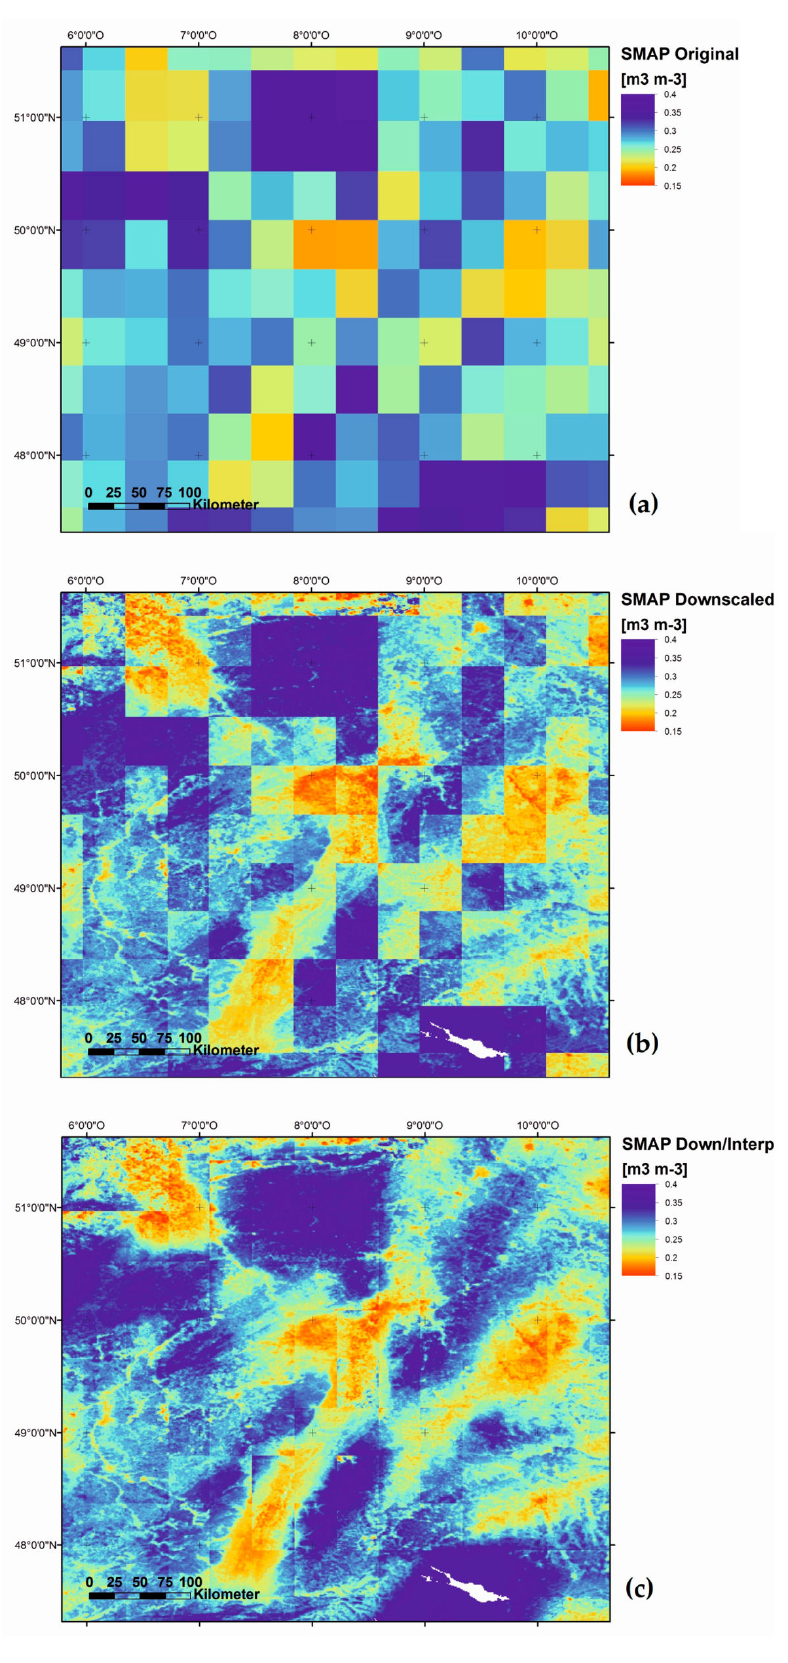
Figure 6. ( a ) Original SMAP soil moisture mean for 2016 and the Upper Rhine valley region; ( b ) Downscaled SMAP soil moisture mean for 2016; and ( c ) Downscaled interpolated SMAP soil moisture mean for